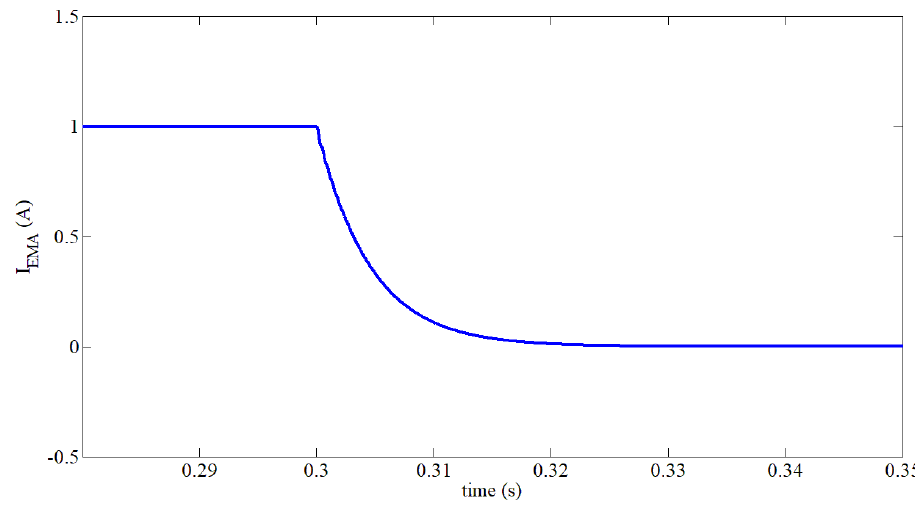
Figure 4. Response of the linear controller for step changes of the input current from 1 A to zero.